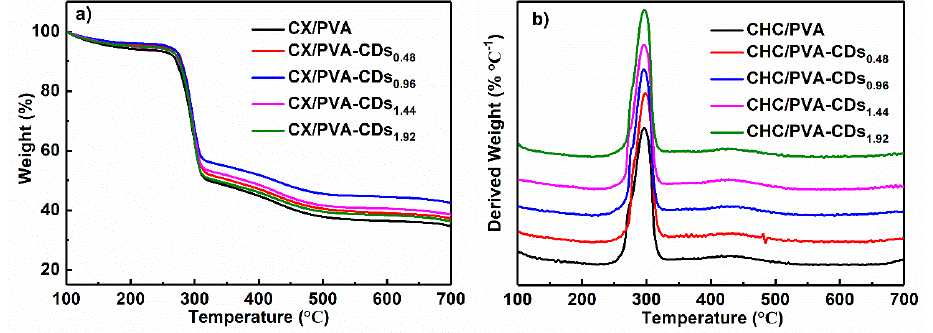
Figure 4. ( a ) TG curves of CX/PVA and CX/PVA-CDs; ( b ) DTG curves of CX/PVA and CX/PVA-CDs .